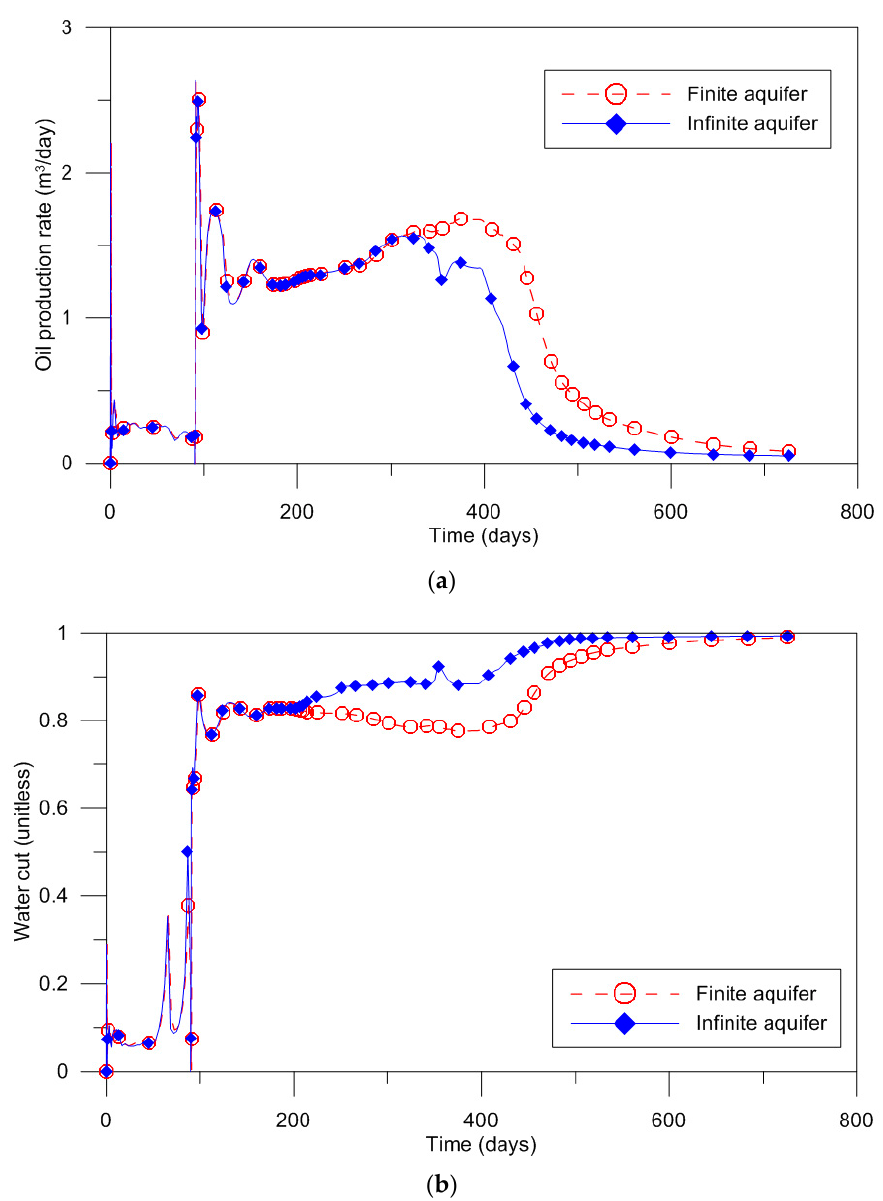
Figure 2. Comparison of liquid production performances with time: ( a ) oil production rate; and ( b ) water cut.